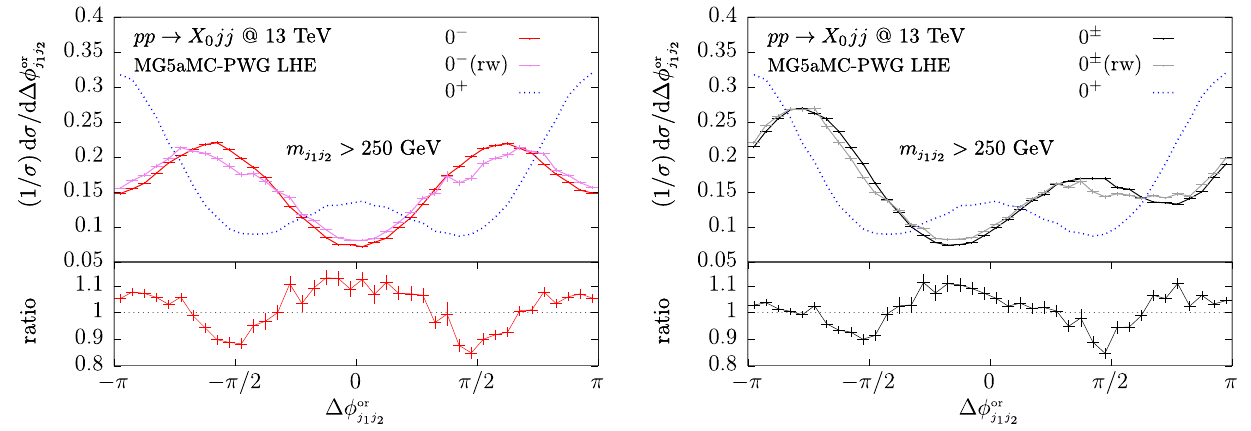
right panel, the CP mixed original distribution in black, the mixed as obtained by reweighting (rw) in gray, and the scalar one in dotted blue. The ratios between the distributions obtained by reweighting and the original ones are also shown